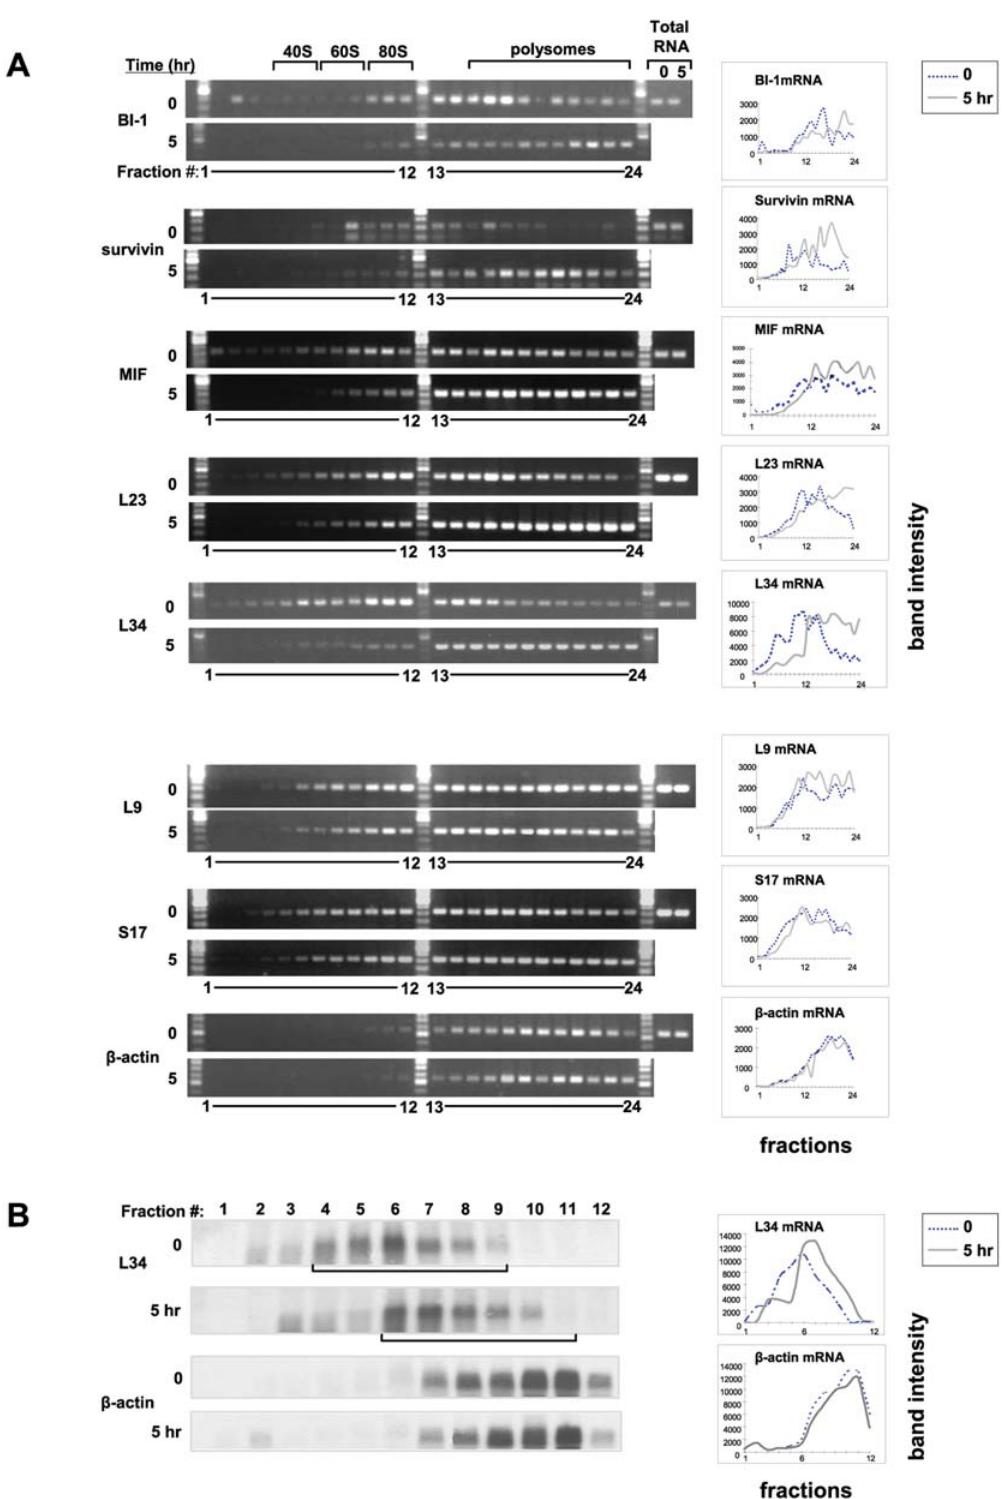
Figure 3. eIF4E induction causes an increase in the recruitment of a subset of mRNAs to polysomes. A) Total and polysomal (24 fractions) RNA from induced ( 2 tet for 5 hr) and uninduced ( + tet for 5 hr) 3T3-tTA-eIF4E cells was reverse transcribed into cDNA. Primers for BI-1, survivin, MIF, L23, L34, L9, S17 and actin were used to assess mRNA levels. Amplified PCR bands from the polysomal fractions were quantified using NIH Image, and absolute values were plotted. B) The effect of eIF4E induction on L34 mRNA distribution was assessed by northern blotting. Polysomal RNA was isolated from induced ( 2 tet for 5 hr) and uninduced ( + tet for 5 hr) 3T3-tTA-eIF4E cells and fractionated into 12 fractions (for purpose of detection). The RNA was loaded on an agarose denaturing gel and transferred to a nitrocellulose membrane. Membranes were probed with radiolabeled murine L34 and actin probes. Bands were quantified using NIH Image, and absolute values were plotted. doi:10.1371/journal.pone.0000242.g003 PLoS ONE |